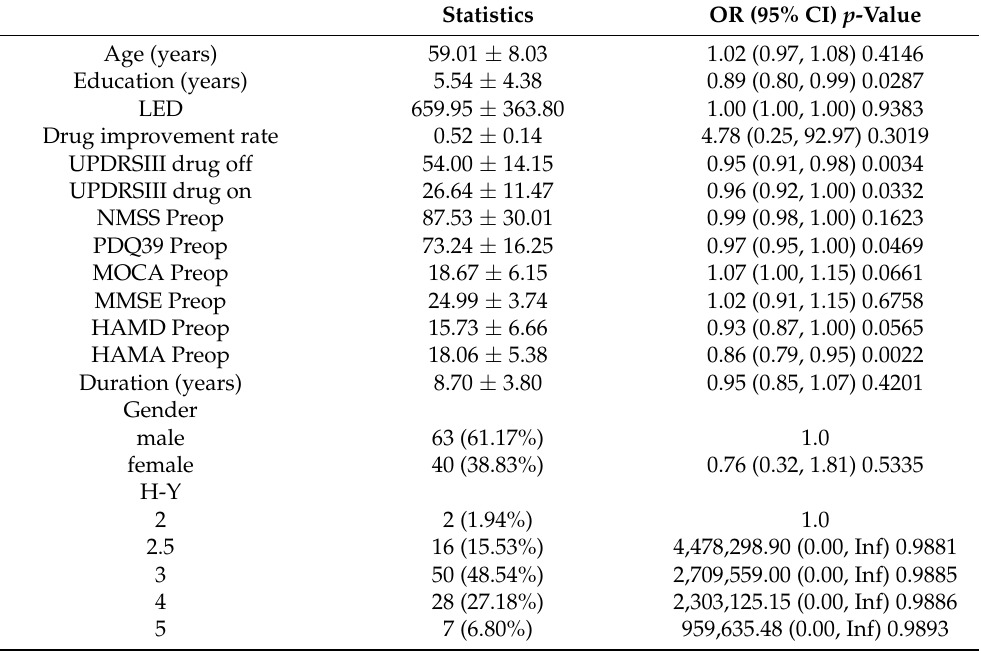
Table 2. Effect of characteristics of patients on the improvement of anxiety.